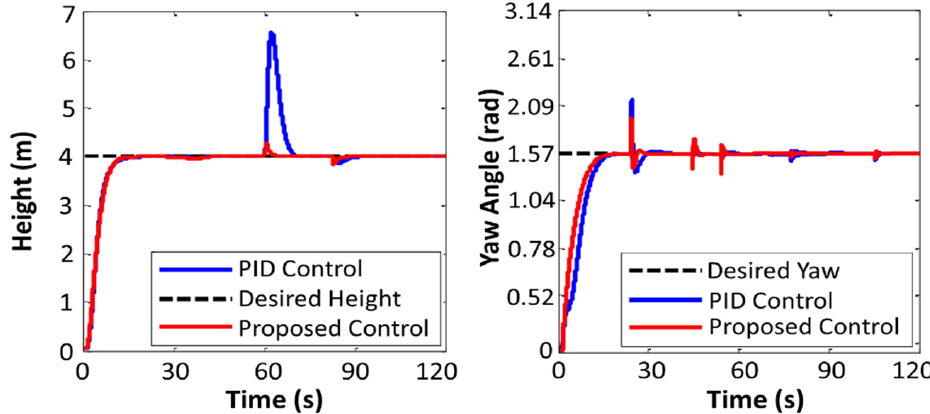
Figure 9. Performance of the quadcopter in attaining desired height and yaw angle.